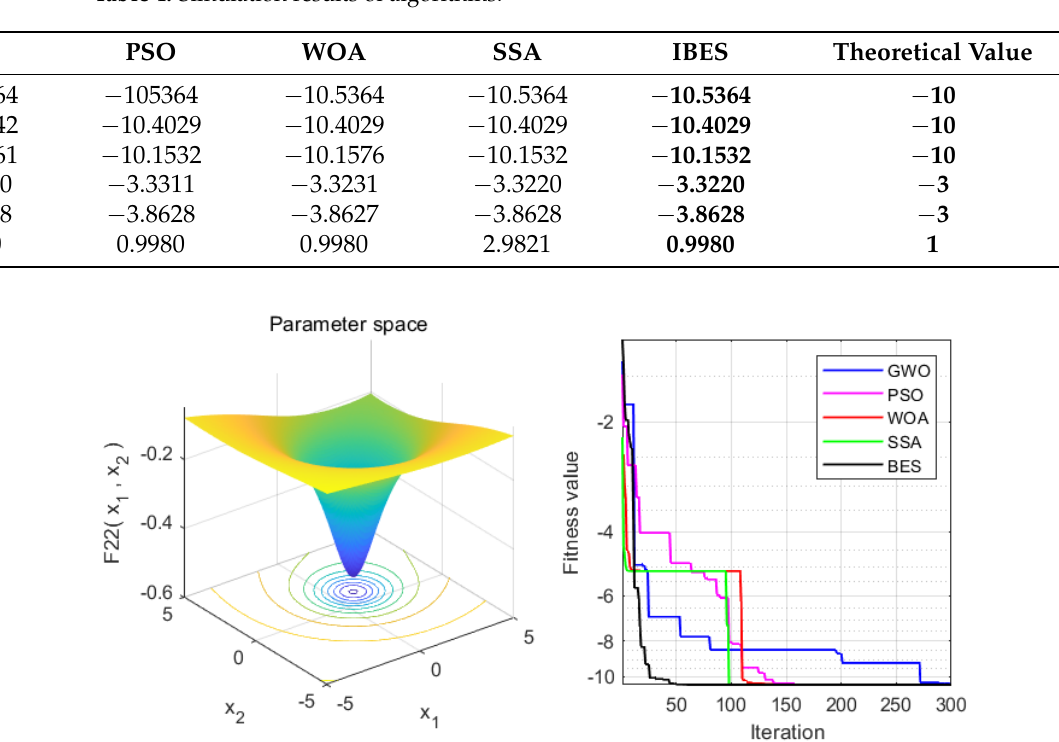
Table 4. Simulation results of algorithms.